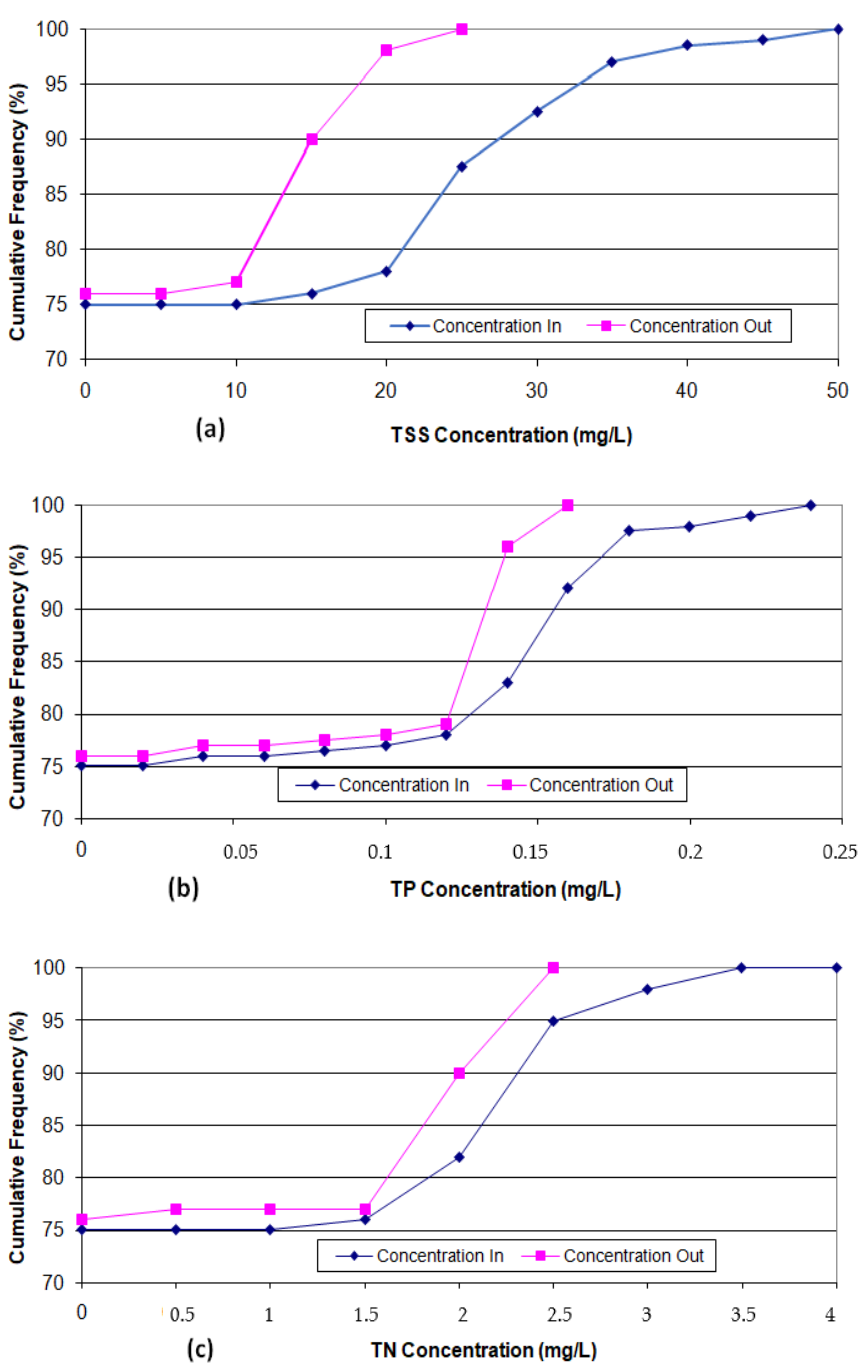
Figure 3. Frequency curves for the daily mean concentrations of ( a ) TSS, ( b ) TP, and ( c ) TN.